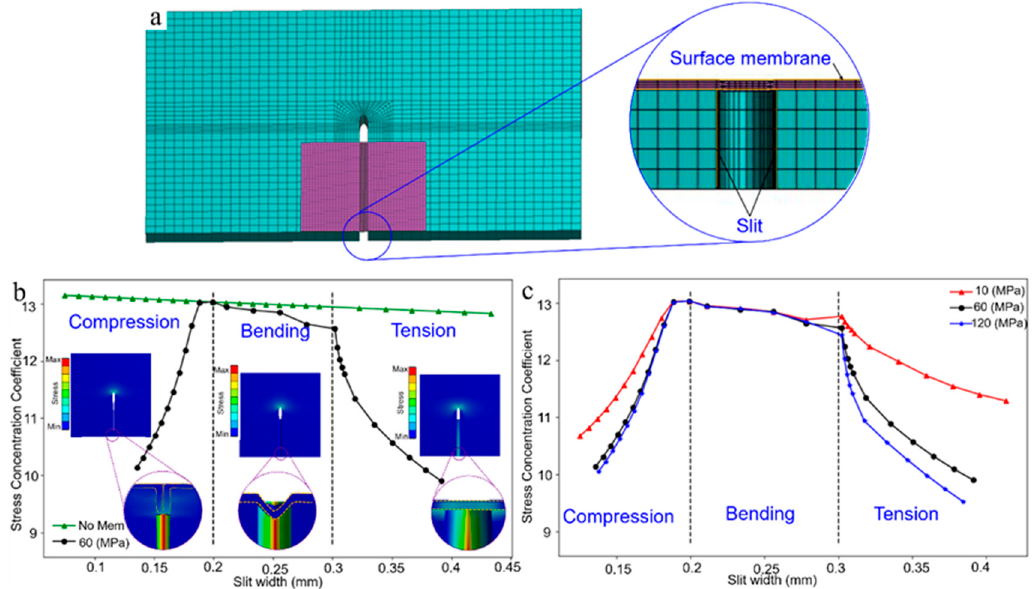
Figure 4. ( a ) Finite element model mesh; ( b ) the curve of stress concentration coefficient as a function of crack width; ( c ) the variation curve of stress concentration coefficient with crack width for different membrane elastic moduli.